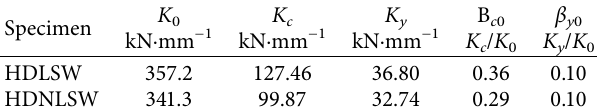
Table 6: Experimental results of stiffness of